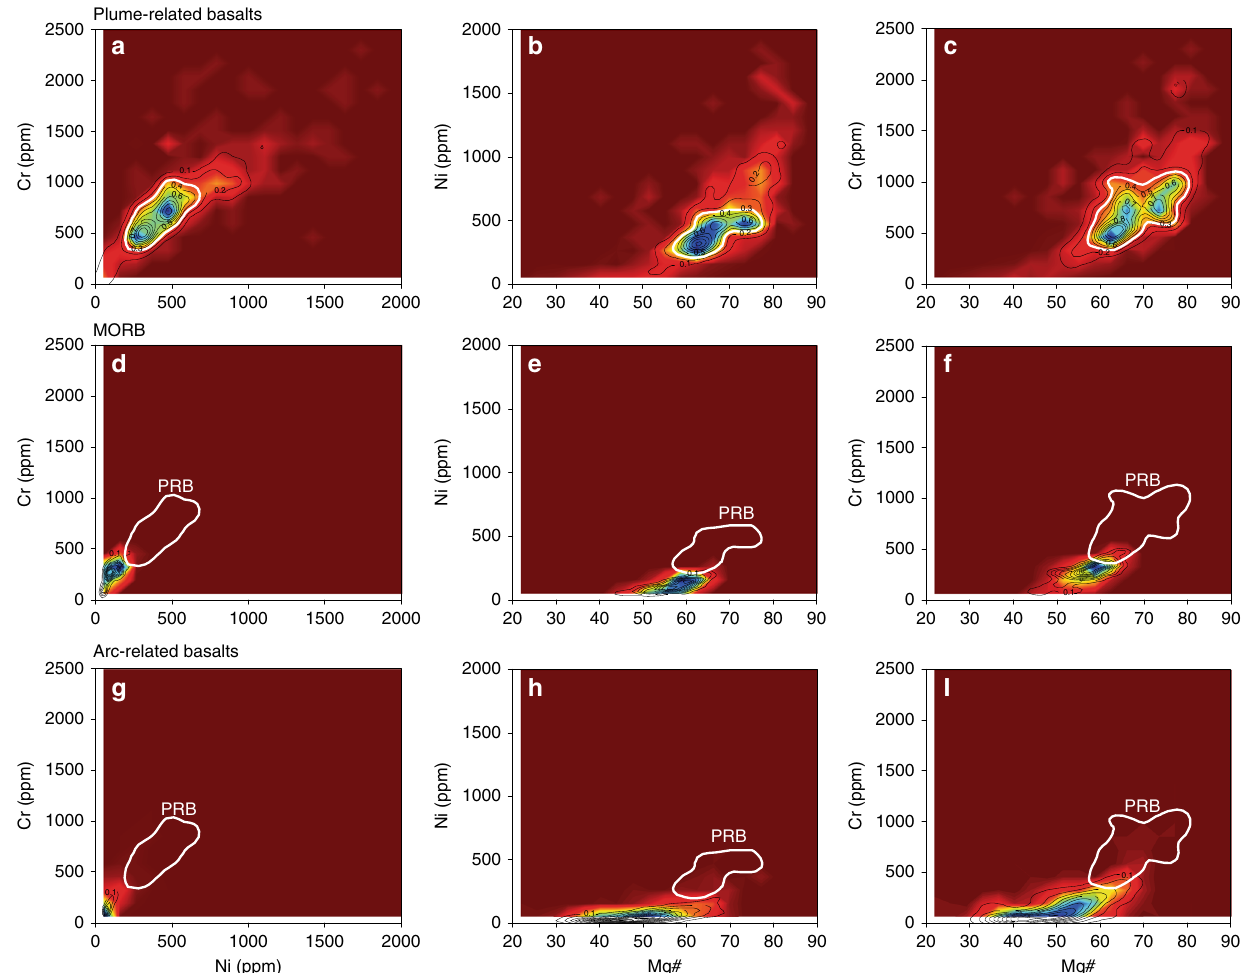
Fig. 1 Density plot of Ni, Cr, and Mg# for different basaltic magmatism types. Panels a , b , and c are density plots of plume-related basalts (PRB) for Ni (ppm) vs. Cr (ppm) and Mg# (100 × MgO/ (MgO + FeO T ) vs. Ni (ppm) and Cr (ppm), respectively. Panels d – f are density plots for mid-ocean ridge basalts (MORB) and g – i panels are for arc-related basalts. Data sources: Georoc and EarthChem (see Methods and Supplementary Data 1). Black contours de fi ne the data density values from high density (blue) to low density (red). The white contour represents 70% of the PRB